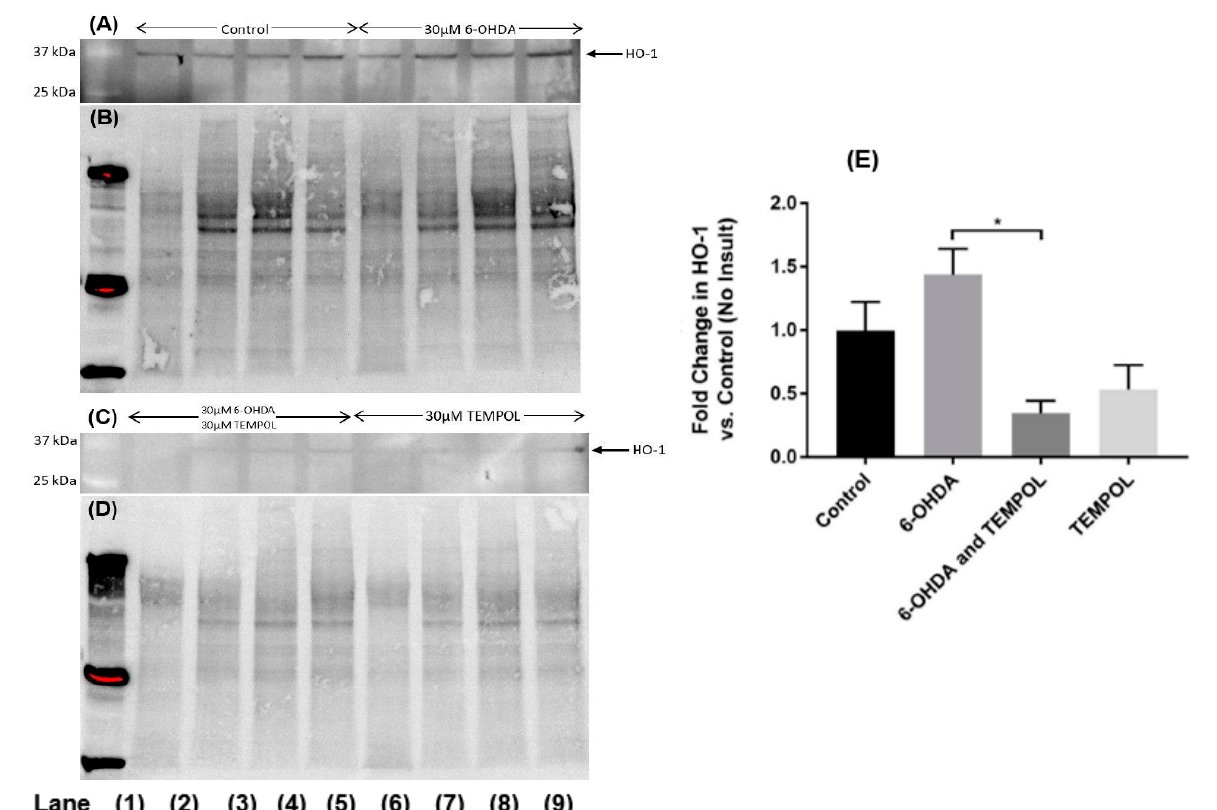
Figure 6. Assessment of Heme Oxygenase 1 protein expression in cultured SH-SY5Y dopaminergic cells after treatment with 6-OHDA ± TEMPOL. Cultured SH-SY5Y dopaminergic cells treated with 30 μ M 6-OHDA ± 30 μ M TEMPOL for 24 h were harvested and lysed before inducible HO-1 protein levels were determined by Western blotting ( A ); representative blot Lane 1: molecular weight standard; Lanes 2–5 vehicle control; Lanes 6–9; cells + 6-OHDA and ( C ) Lanes 2–5; 30 μ M 6-OHDA + 30 μ M TEMPOL; Lanes 6–9; cells + 30 μ M TEMPOL alone). Panel ( E ) corresponding densitometric analysis of protein bands with normalization to corresponding in gel total protein assessed in the same SDS-PAGE blot (in gel protein staining shown in panels ( B , D ) prior to transfer step). Data is shown as mean ± SEM, n = 4 independent experiments. * Different to cell samples treated with 6-OHDA alone; p ≤ 0.01.